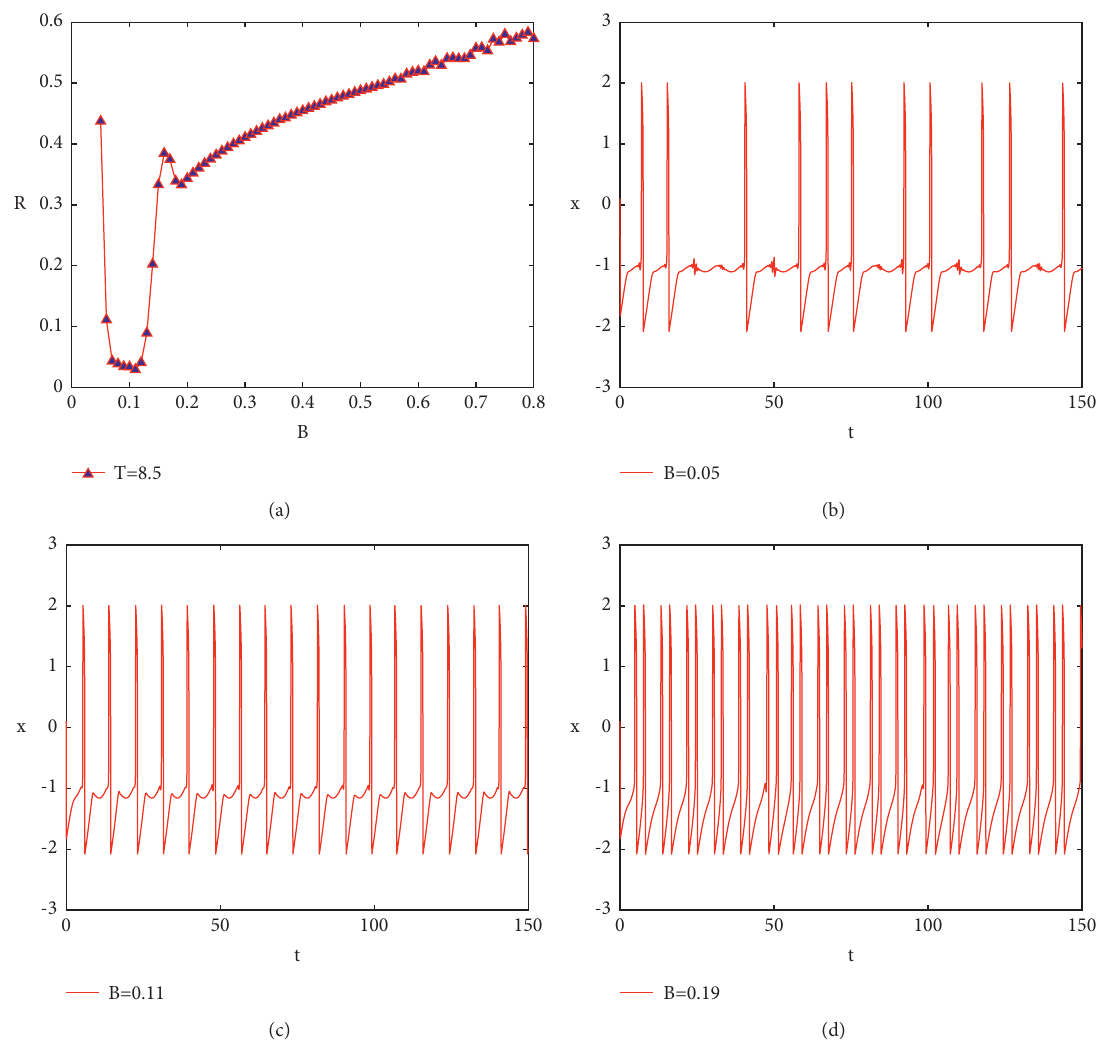
Figure 6: When phase noise period T � 8 . 5, the plot of the coherence resonance coefficient R varying with phase noise amplitude B and the time evolution diagram of the system membrane potential x . (a) Variation of R with B ; (b) B � 0 . 05; (c) B � 0 . 11; (d) B � 0 .